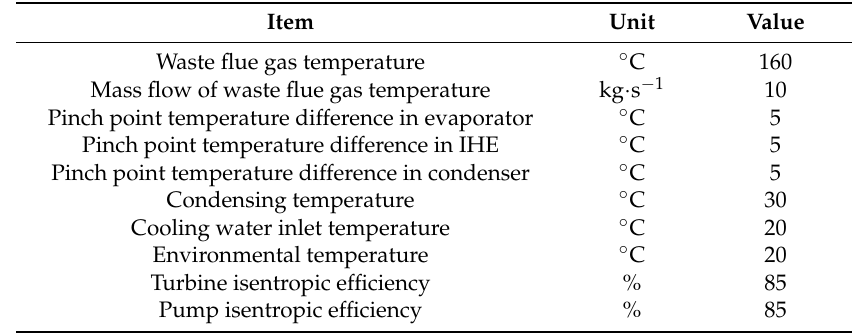
Table 2. Waste flue gas parameters and simulation conditions assumed for the ORC System.